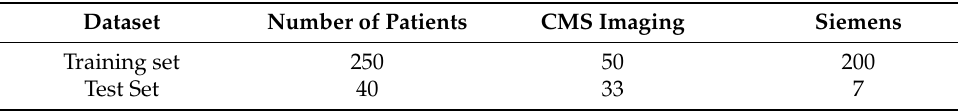
Table 2. Dataset statistics in terms of different scanner.